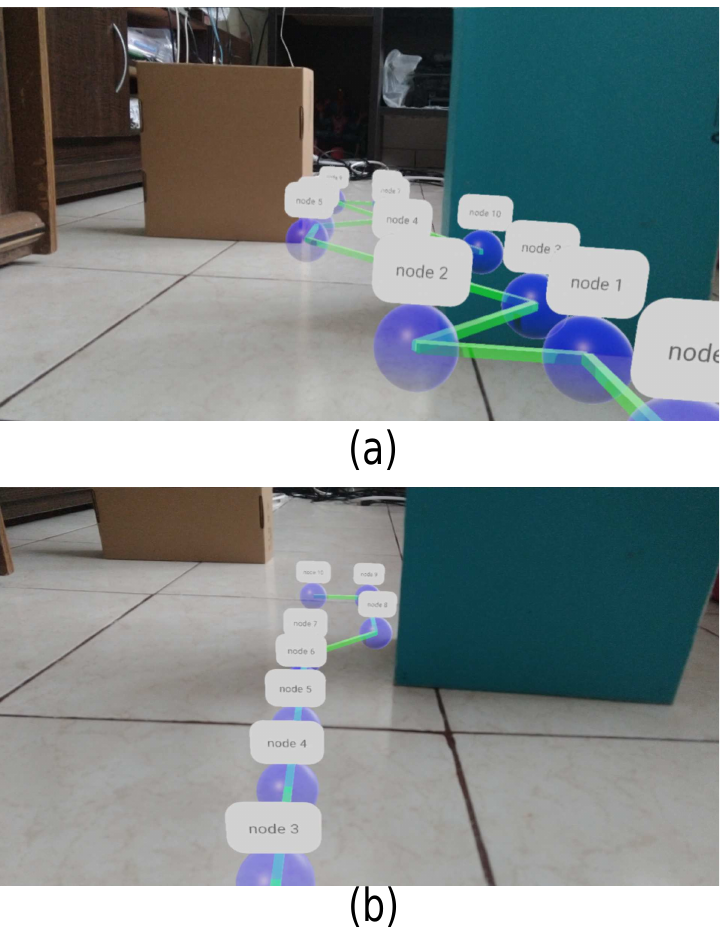
Figure 24. Generated paths using augmented reality. ( a ) The path shows avoiding obstacles, which describes the movement to avoid an object. ( b ) The path begins with a collision-free path and, when approaching an obstacle, turns to avoid